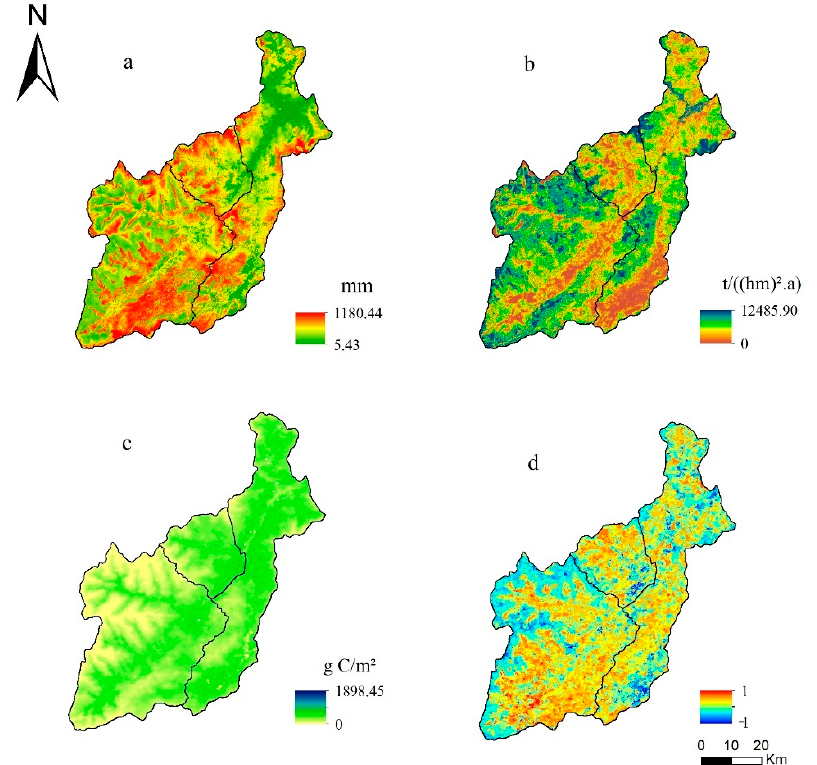
Figure 5. Spatial distribution of ecosystem services in 2015 and the trend during 2000–2015: ( a ) water conservation in 2015, ( b ) soil conservation in 2015, ( c ) carbon fixation in 2015, and ( d ) the trend of three ecosystem services during 2000–2015.